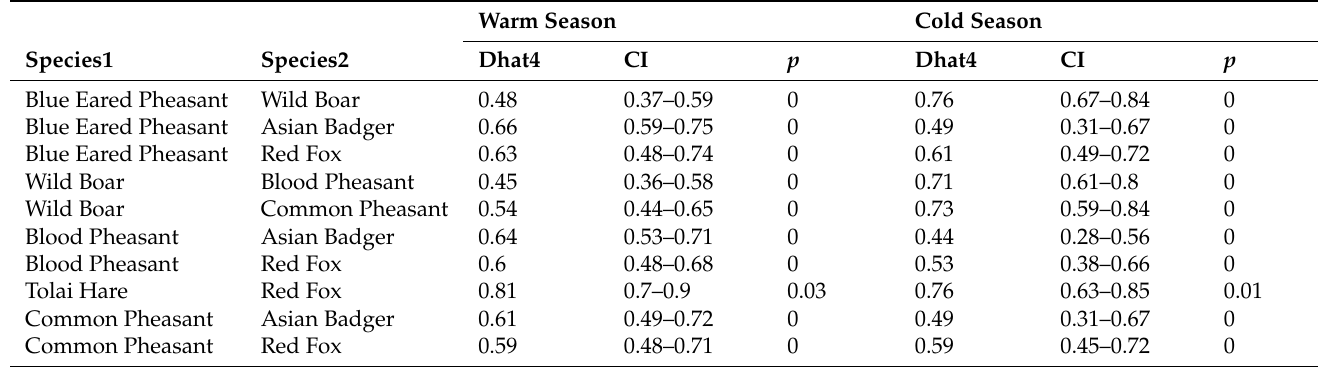
Table 3. Coefficients of daily activity overlapping (Dhat4), and p -level ( p ) and their confidence intervals (CI) for predatory species on the eastern Qinghai-Tibet Plateau in 2017–2020.